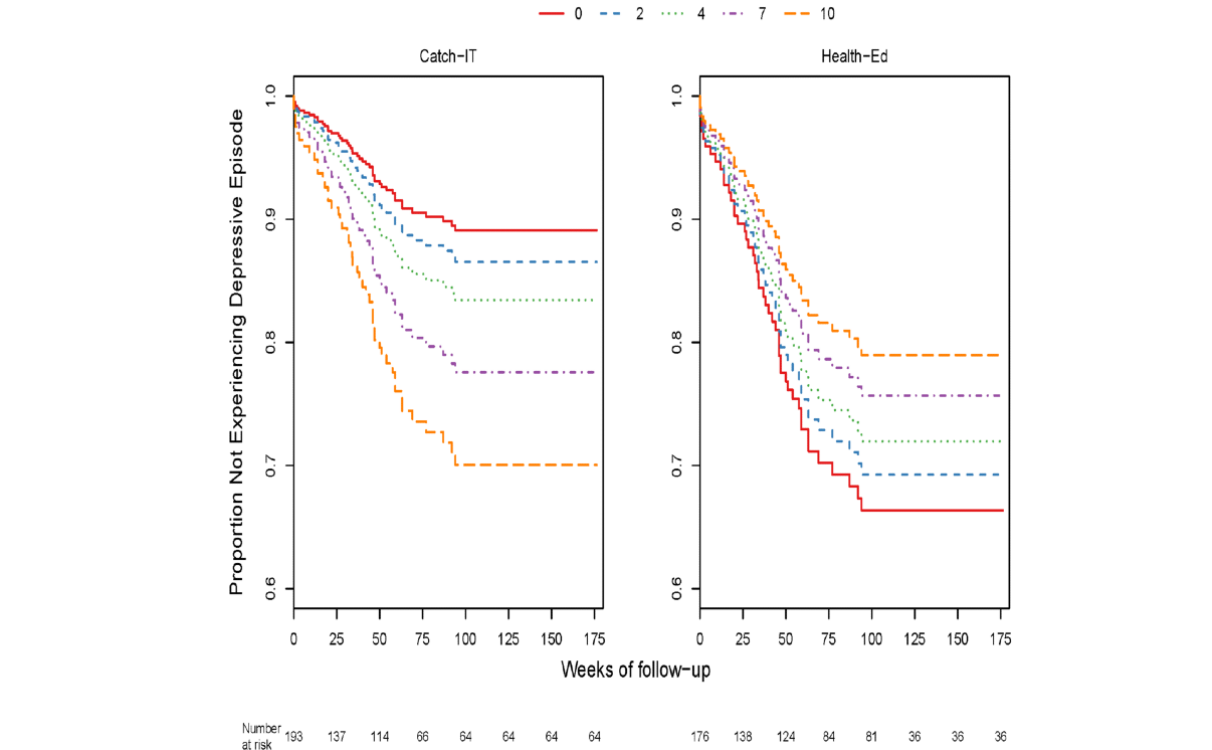
Figure 3. Adolescent Beck Hopelessness Scale score at at baseline and time to Depression Symptom Rating>3–event at 24